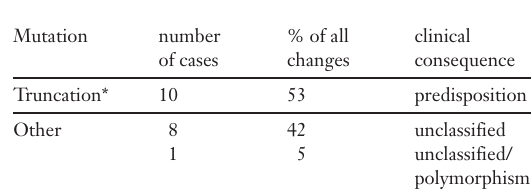
Frequency of truncating mutations in 19 Swiss